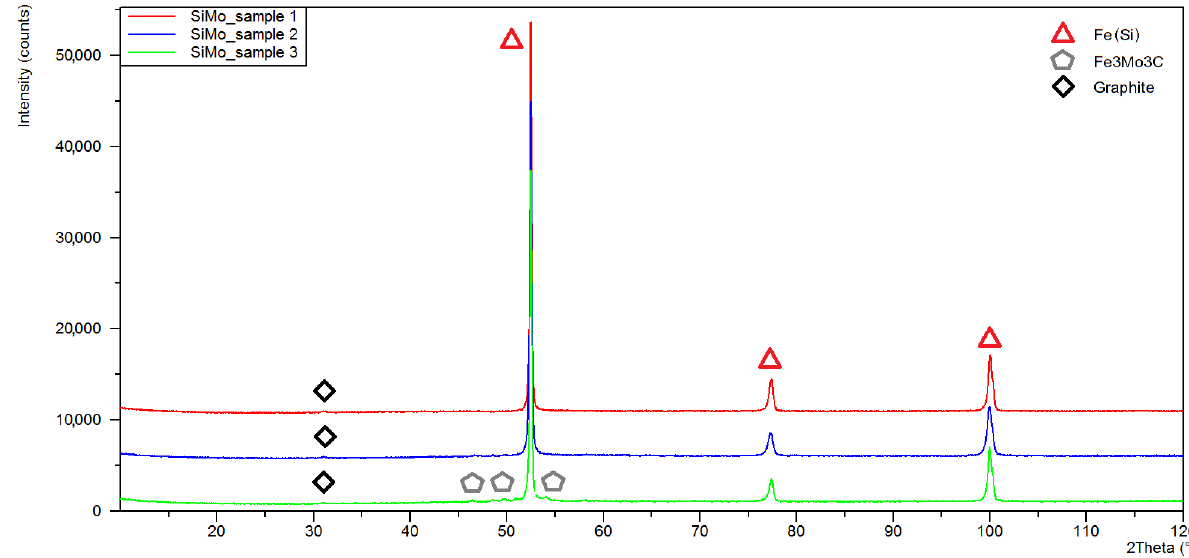
Figure 5. The X-ray diffraction patterns obtained for SiMo cast iron samples in the initial state; sample 1 (red line), sample 2 (blue line), sample 3 (green line).